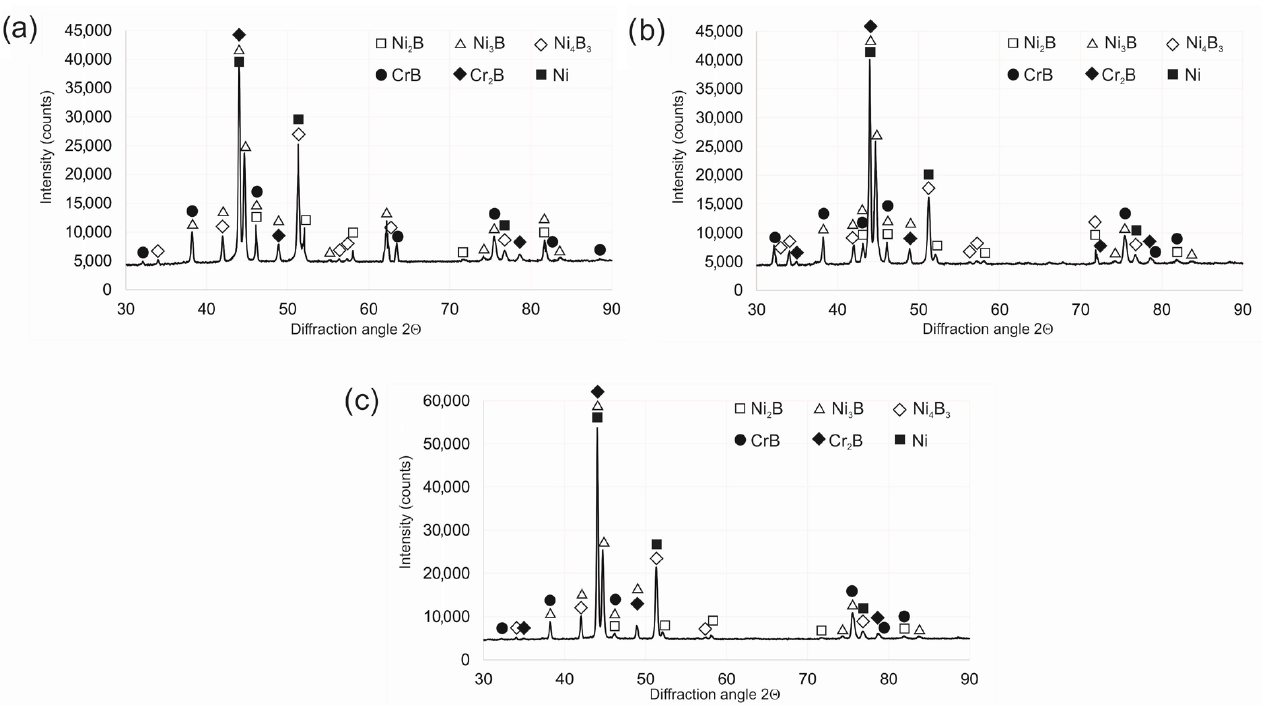
Figure 7. XRD patterns Nimonic 80 alloy after laser boriding at laser beam power of ( a ) 1.3 kW, ( b ) 1.56 kW, and ( c ) 1.95 kW.